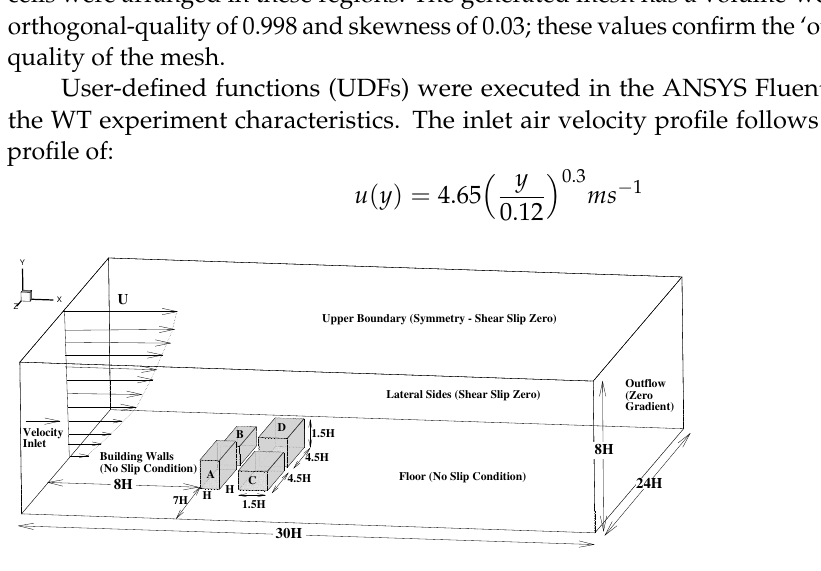
Figure 1. Computational domain and boundary conditions for numerical